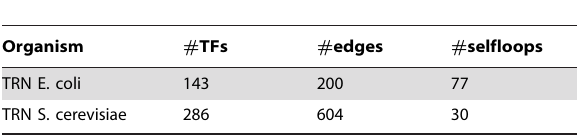
Table 2. Transcriptional regulatory networks.